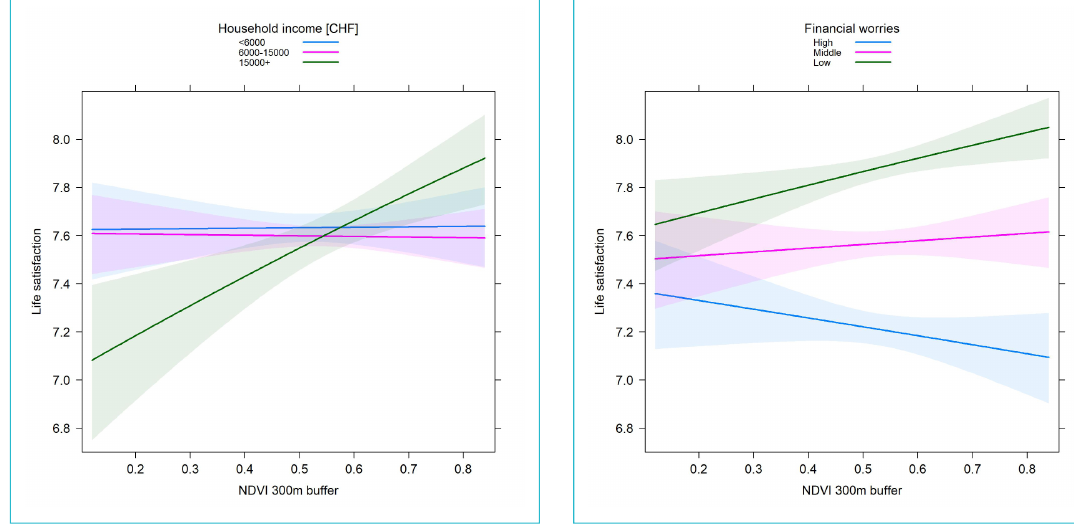
Figure 4: NDVI association with life satisfaction by household in- come, adjusted for life satisfaction in the past, age categories, sex, financial worries, canton, degree of urbanisation, and month of en- try.